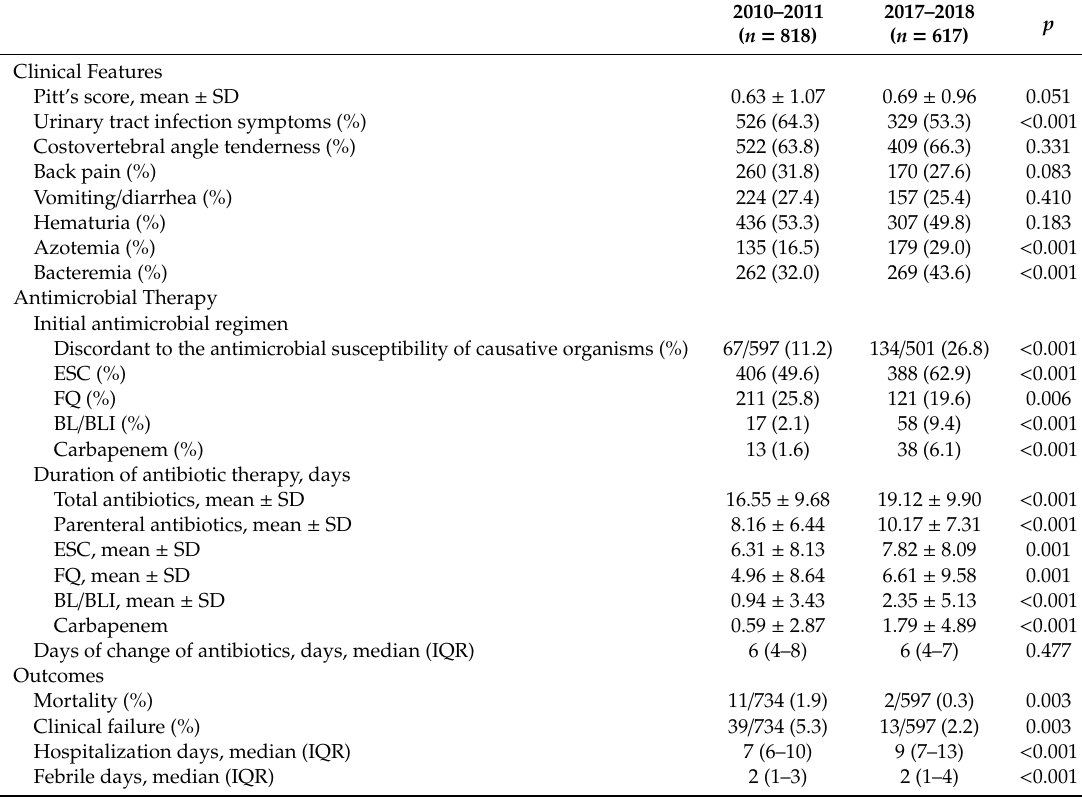
Table 4. Comparison of clinical characteristics of patients with community-acquired acute